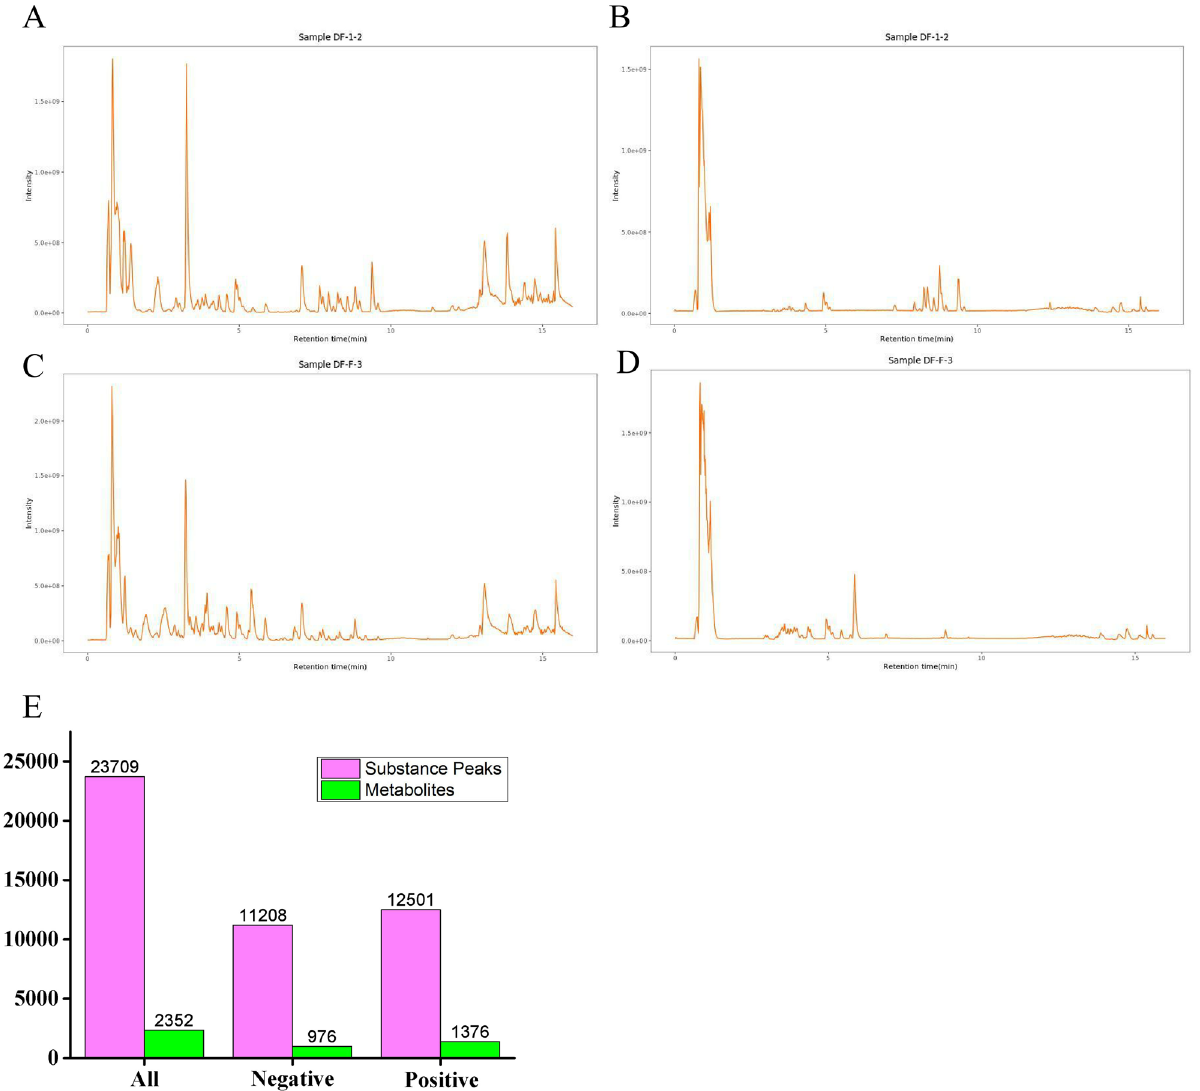
Figure 1. TICs of methanol extracts from FSD and TPFD samples and the global metabolites identified. ( A ): TICs of FSD samples (ESI+). ( B ): TICs of FSD samples (ESI–). ( C ): TICs of TPFD samples (ESI+). ( D ): TICs of TPFD samples (ESI–). E: Numbers of the substance peaks and identified